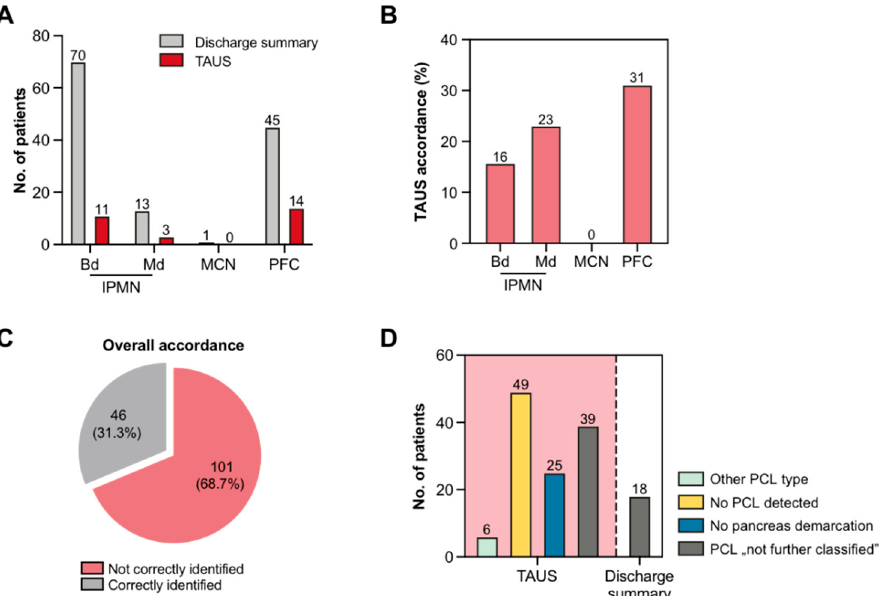
Figure 1. Diagnostic accordance between TAUS and final discharge summaries. ( A ) Frequency of different PCL entities as reported by TAUS and discharge summaries (in absolute numbers). ( B ) Frequency of different PCL entities as reported by TAUS (in percentage numbers). ( C ) Degree of overall accordance between TAUS and final discharge summaries. ( D ) TAUS-related causes of discrepant findings. Transabdominal ultrasound, TAUS; intraductal papillary mucinous neoplasm, IPMN; main duct type-IPMN, md-IPMN; branch duct type-IPMN, bd-IPMN; mucinous cystic neoplasm, MCN; post-pancreatitis fluid collection, PFC; pancreatic cystic lesion, PCL.